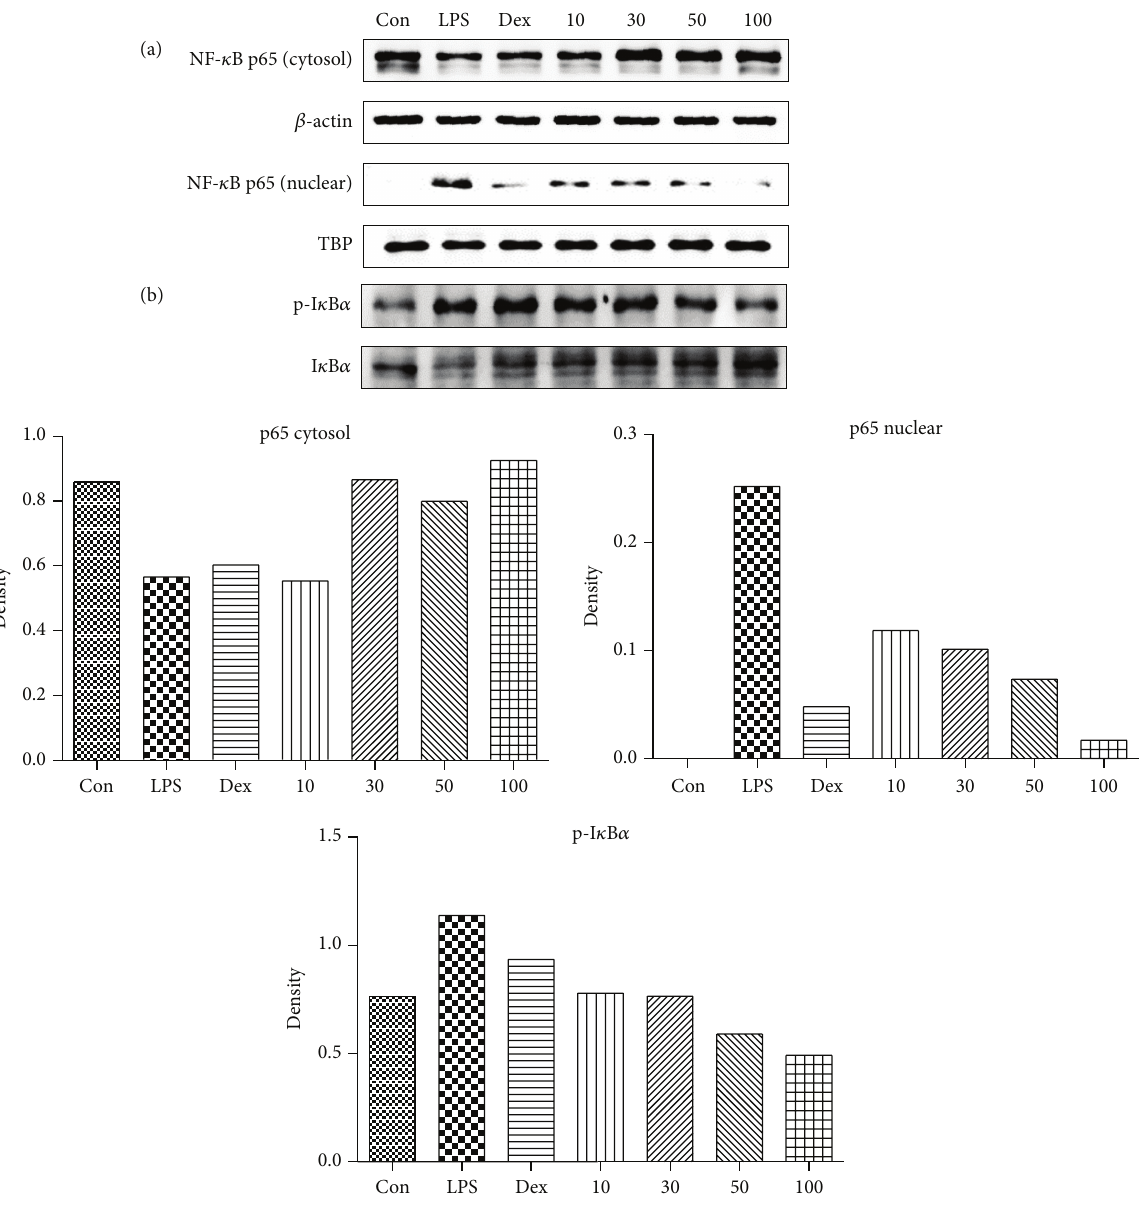
Figure 4: Effects of RRE treatment on (a) NF- 𝜅 B p65 translocation into the nucleus and (b) phosphorylation of I 𝜅 B 𝛼 in RAW 264.7 cells. Cells were pretreated with RRE for 1h and stimulated with LPS for an additional (a) 1h or (b) 30 min. 𝛽 -actin and TATA box-binding protein (TBP) were used for cytosolic and nuclear control proteins, respectively. Results are representative of three independent